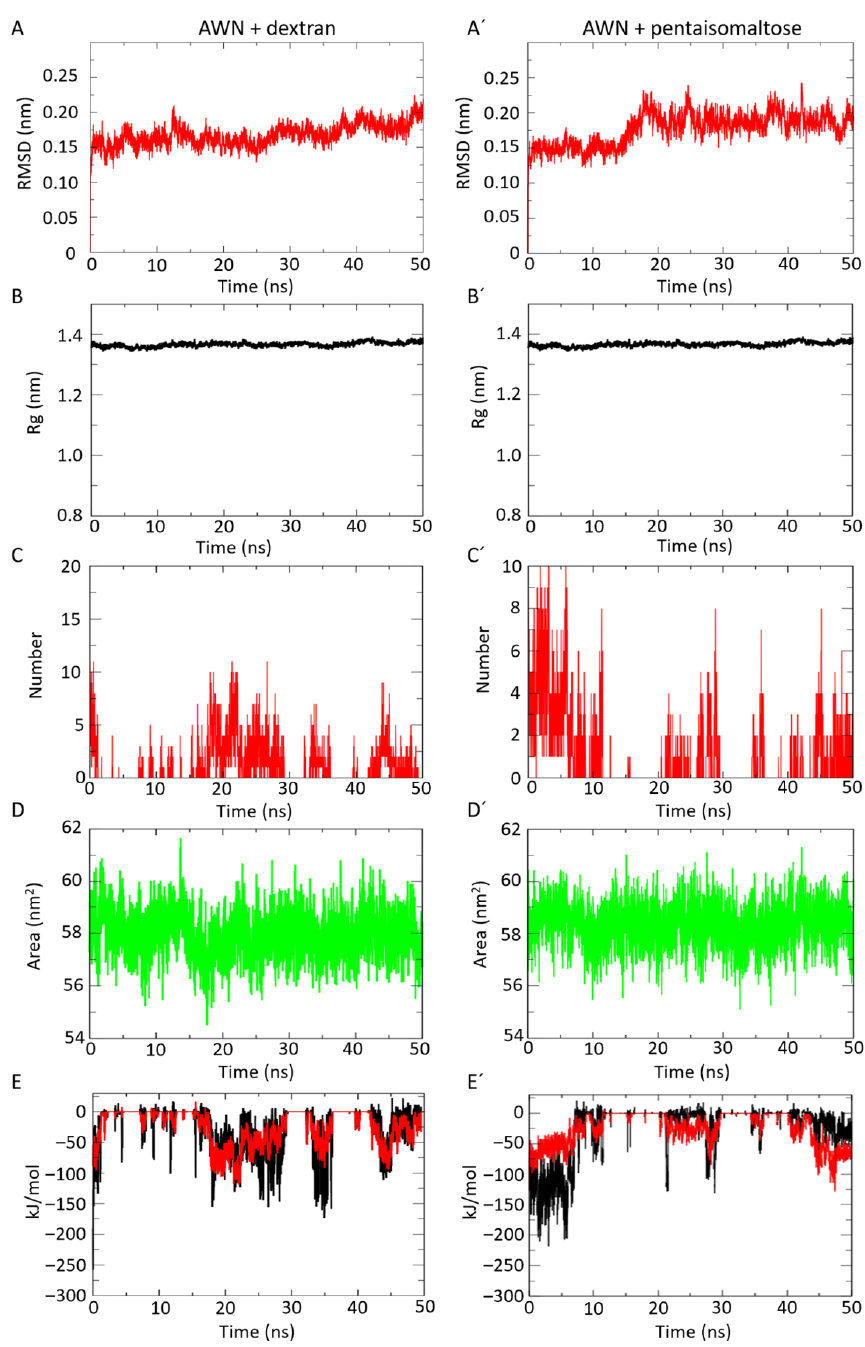
Figure 2. Molecular dynamics simulation analysis of AWN spermadhesin with dextran ( A–E ) or pentaisomaltose ( A’–E’ ). ( A , A’ ) Protein–polysaccharide complex RMSD plot showing very stable interaction. ( B , B’ ) Radius of gyration (Rg) plot for protein-polysaccharide complex showing the higher structural compactness of AWN spermadhesin in the presence of dextran or pentaisomaltose. ( C , C’ ) Plot for H bonds for protein–polysaccharide interacting complex showing six stable hydrogen bonds. ( D , D’ ) Solvent accessible surface area (SASA) plot for protein–polysaccharide complex. ( E , E’ ) Short-range electrostatic (Coul-SR) (black line) and Van der Waals or hydrophobic (LJ-SR) interaction energies (red line).